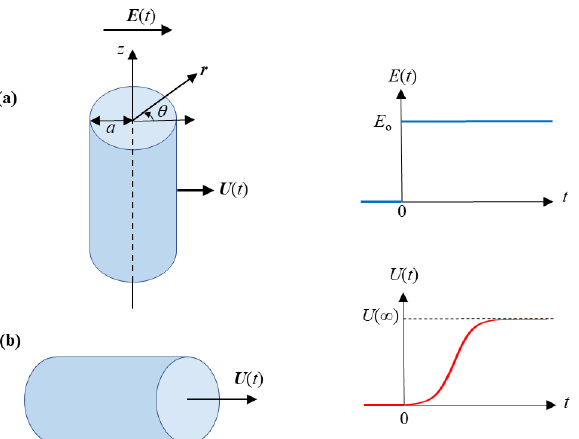
Figure 1. Cylindrical colloidal particle of radius a and zeta potential ζ moving with a transient velocity U ( t ) in an applied step electric field E ( t ). The electric field E ( t ) is perpendicular to the cylinder axis ( a ) or parallel to it ( b ). U ( ∞ ) is the magnitude of U ( ∞ ) at t = ∞ . The initial and boundary conditions for u ( r , t ) and v i ( r , t ) are given by